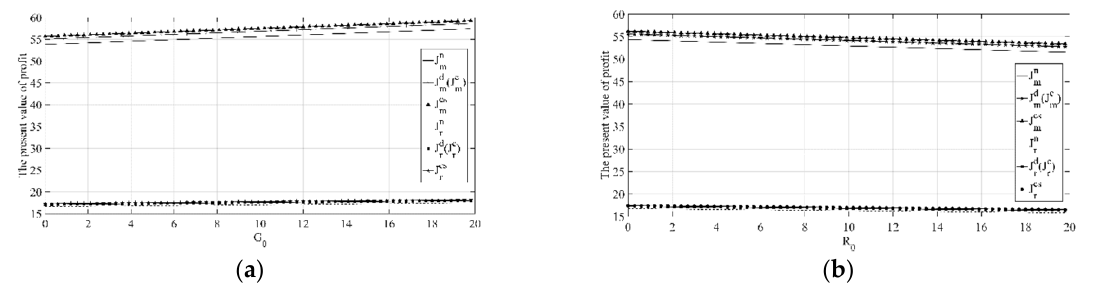
Figure 6. The impact of initial low-carbon goodwill and reference low-carbon level on profits. ( a ) The effect of G 0 on profits. ( b ) The effect of R 0 on profits.